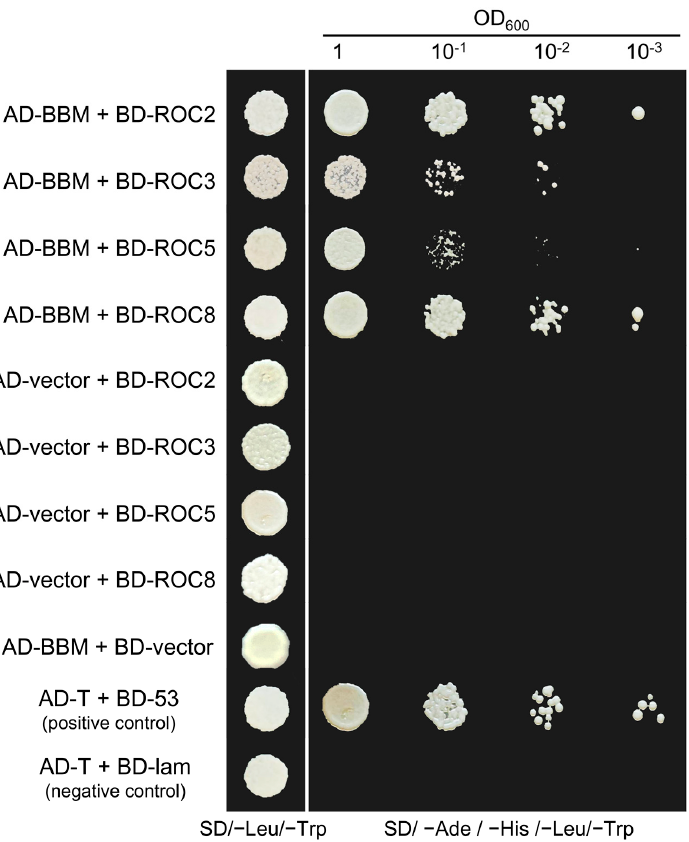
Figure 7. Yeast-two hybrid assay for EgHD-ZIP IV proteins and EgBBM interactions. EgROC2, EgROC3, EgROC5, and EgROC8 interacted with EgBBM. Transformed yeast cells were grown on SD/ − Trp/ − Leu and SD/ − Trp/ − Leu/ − His/ − Ade media. AD and BD indicated activation domain and binding domain fused with proteins,